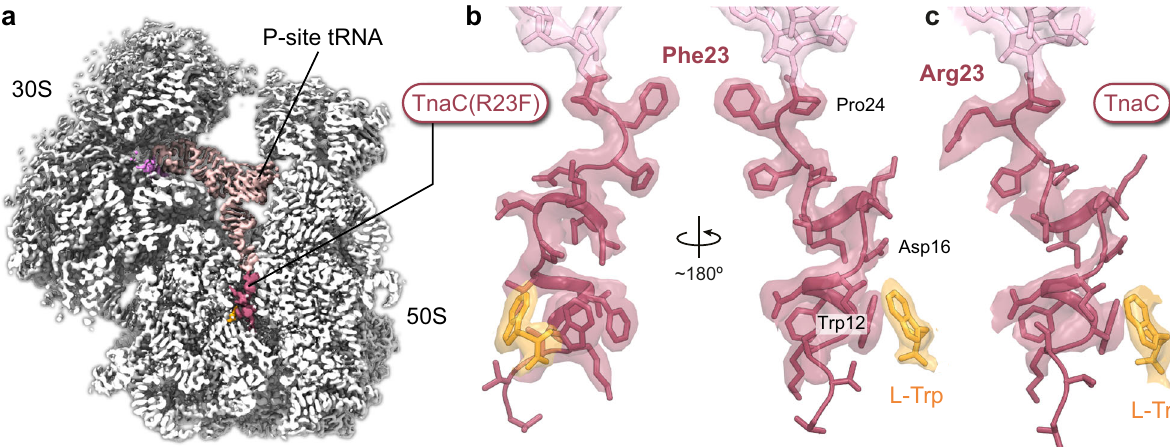
Fig. 2 Cryo-EM structure of a TnaC(R23F) – 70S complex. a Cross-section of a cryo-EM density map of the TnaC(R23F)-70S complex showing the 70S ribosome (white), and the TnaC(R23F) peptide (red) in the nascent polypeptide exit tunnel attached to tRNA Pro (pink) in the ribosomal P-site, and the mRNA (dark pink). A bound L-Trp molecule (orange) can be seen adjacent to the TnaC(R23F) peptide. b Close-ups of the TnaC(R23F) peptide attached to the P-site tRNA and of the L-Trp molecule, showing the modeled structure and the corresponding density. c Close-up of the wild-type TnaC peptide attached to the P-site tRNA and interacting with a single L-Trp molecule. Coloring in panels ( b , c ) is as in panel ( a ). In each of the three panels, segmented densities for the ribosome, tRNA Pro , mRNA, TnaC, and L-Trp are shown using the same contour